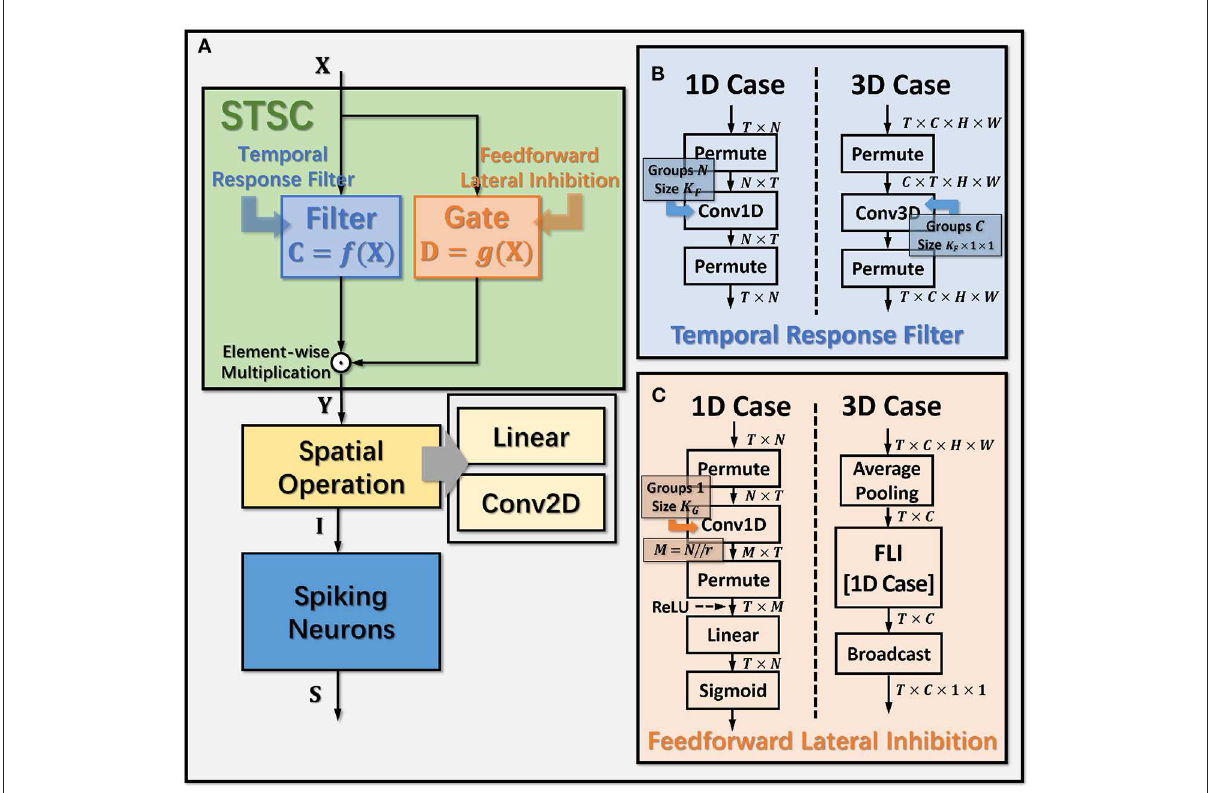
FIGURE3 Operation details of STSC modules. (A) Connection Implementation between TRF, FLI, and Spatial Operations, where ⊙ denotes broadcast element-wise multiplication; (B, C) Tensor Computations in TRF and FLI modules, where T , C , H , W refer to tensor dimensions of time, channel, height, and